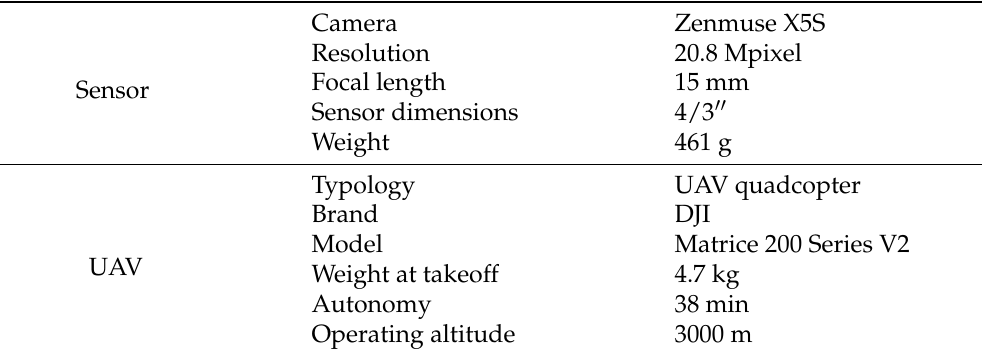
Table 5. Technical specification of the instrumentation used for the UAV photogrammetry surveys in Alba